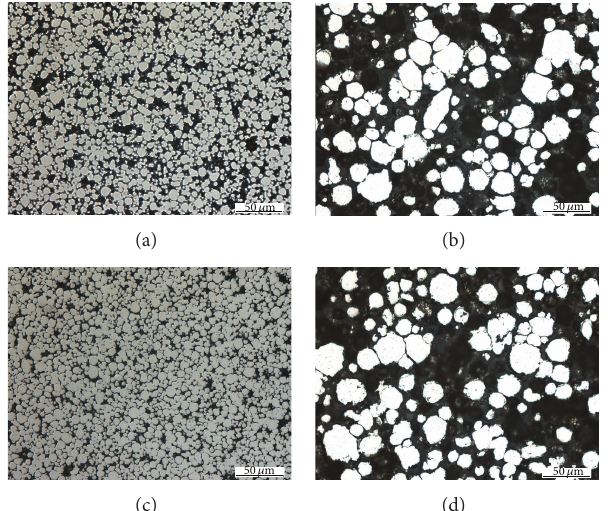
Figure 3: Microscopic pictures of the sintered structures from nickel powders. (a) Grain size of 10 𝜇 m, sintering temperature of 600 ∘ C, and sintering time of 30 min. (b) Grain size of 25 𝜇 m, sintering temperature of 600 ∘ C, and sintering time of 30min. (c) Grain size of 10 𝜇 m, sintering temperature of 600 ∘ C, and sintering time of 90min. (d) Grain size of 25 𝜇 m, sintering temperature of 600 ∘ C, and sintering time of 90 min.